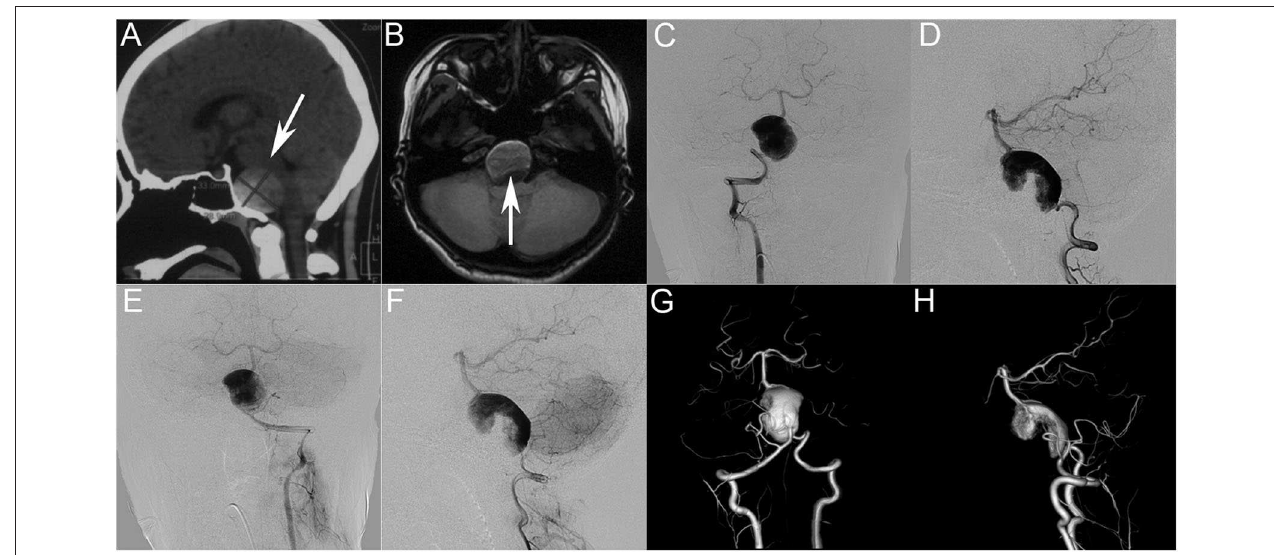
FIGURE 1 | (A,B) Preoperative computed tomography (A) and magnetic resonance imaging (B) showing a giant intracranial mass effect (white arrow) in the basal ganglia region. Preoperative anteroposterior angiograms of the right vertebral artery (C,D) and left vertebral artery (E,F) showing a giant dissecting aneurysm in the vertebrobasilar artery. (G,H) Three-dimensional reconstruction showing that the dissecting aneurysm straddles bilateral vertebral arteries and that the anterior inferior cerebellar artery arises from the